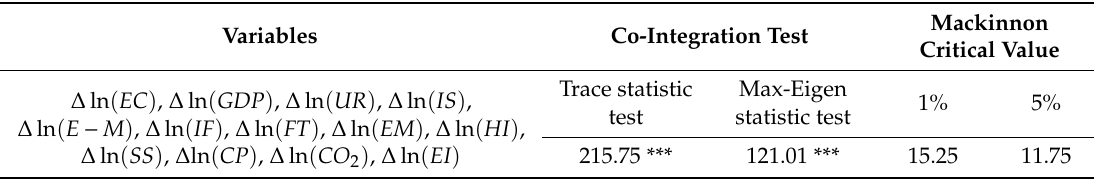
Table 2. Co-integration test by Johansen and